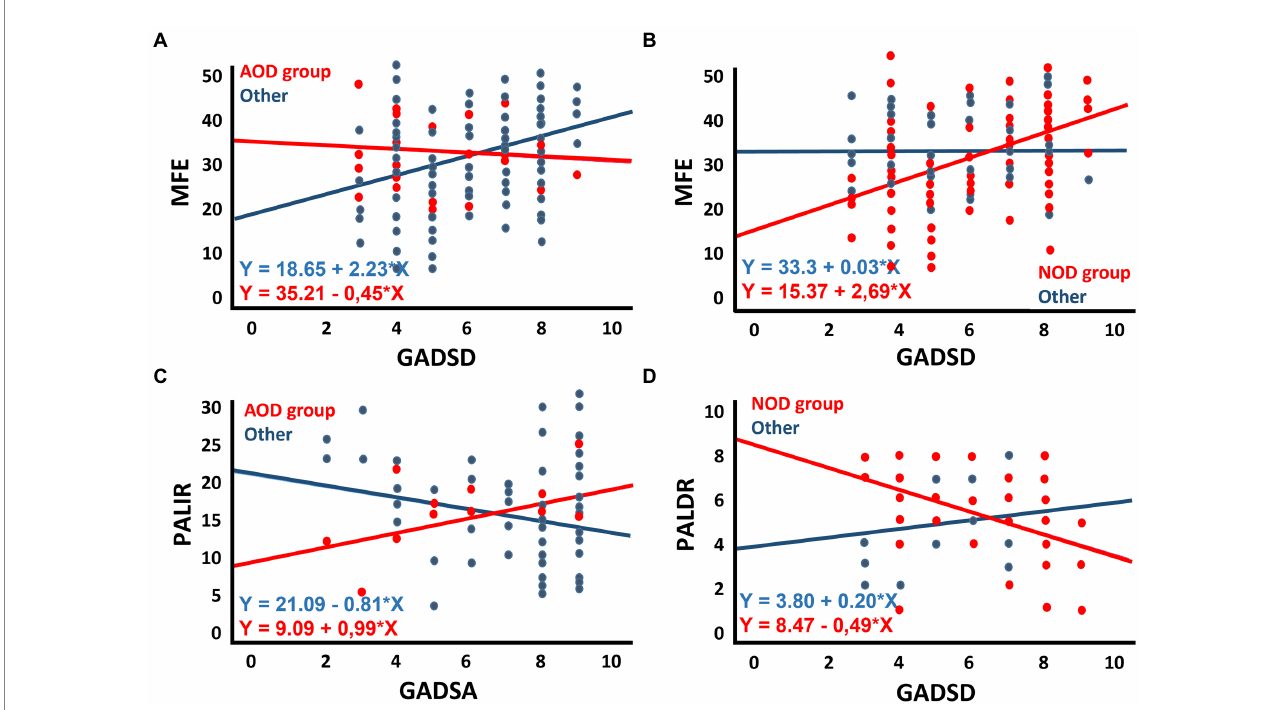
FIGURE 2 Scatter plots illustrating: (A) the interaction of depressive symptomatology (GADSD) in the groups of participants with or without acute olfactory dysfunction (with: AOD) in predicting memory complaints (MFE); (B) the interaction of depressive symptomatology (GADSD) in the groups of participants with or without symptoms of olfactory dysfunction (without: NOD) in predicting memory complaints (MFE); (C) the interaction of anxious symptomatology (GADSA) in the groups of participants with or without acute olfactory dysfunction (with: AOD) in predicting immediate ability to recall verbal episodic information (PALIR); (D) the interaction of depressive symptomatology (GADSD) in the groups of participants with or without olfactory dysfunction (without: NOD) in predicting delayed ability to recall verbal episodic information (PALDR).